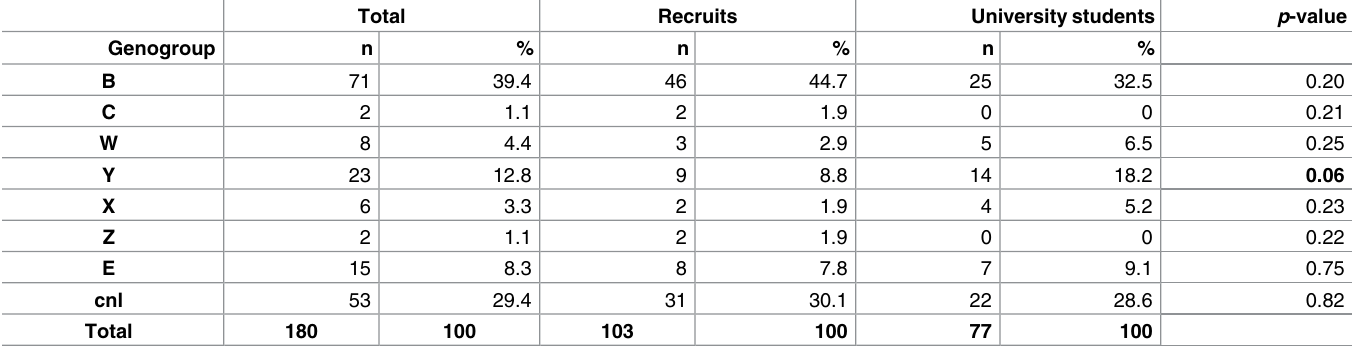
Table 2. Genogroup distribution among the carrierisolates in both studied